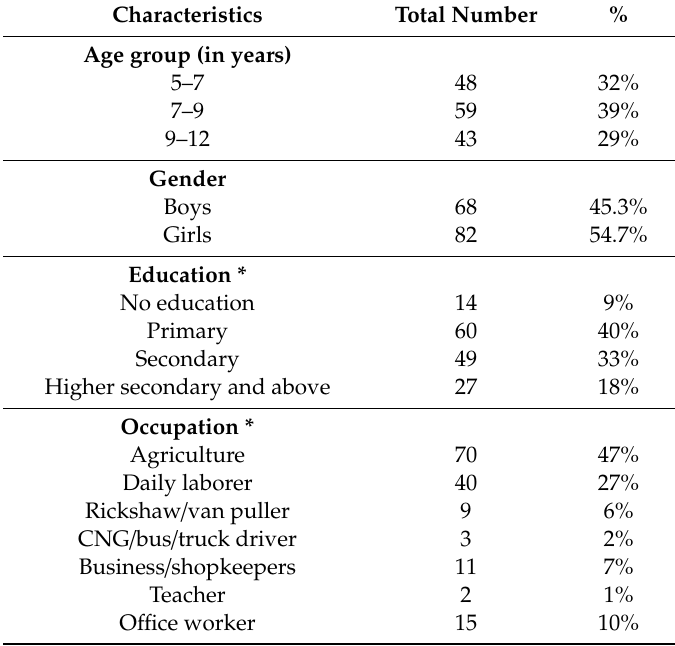
Table 1. Socio-demographic characteristics of the sample population of children.